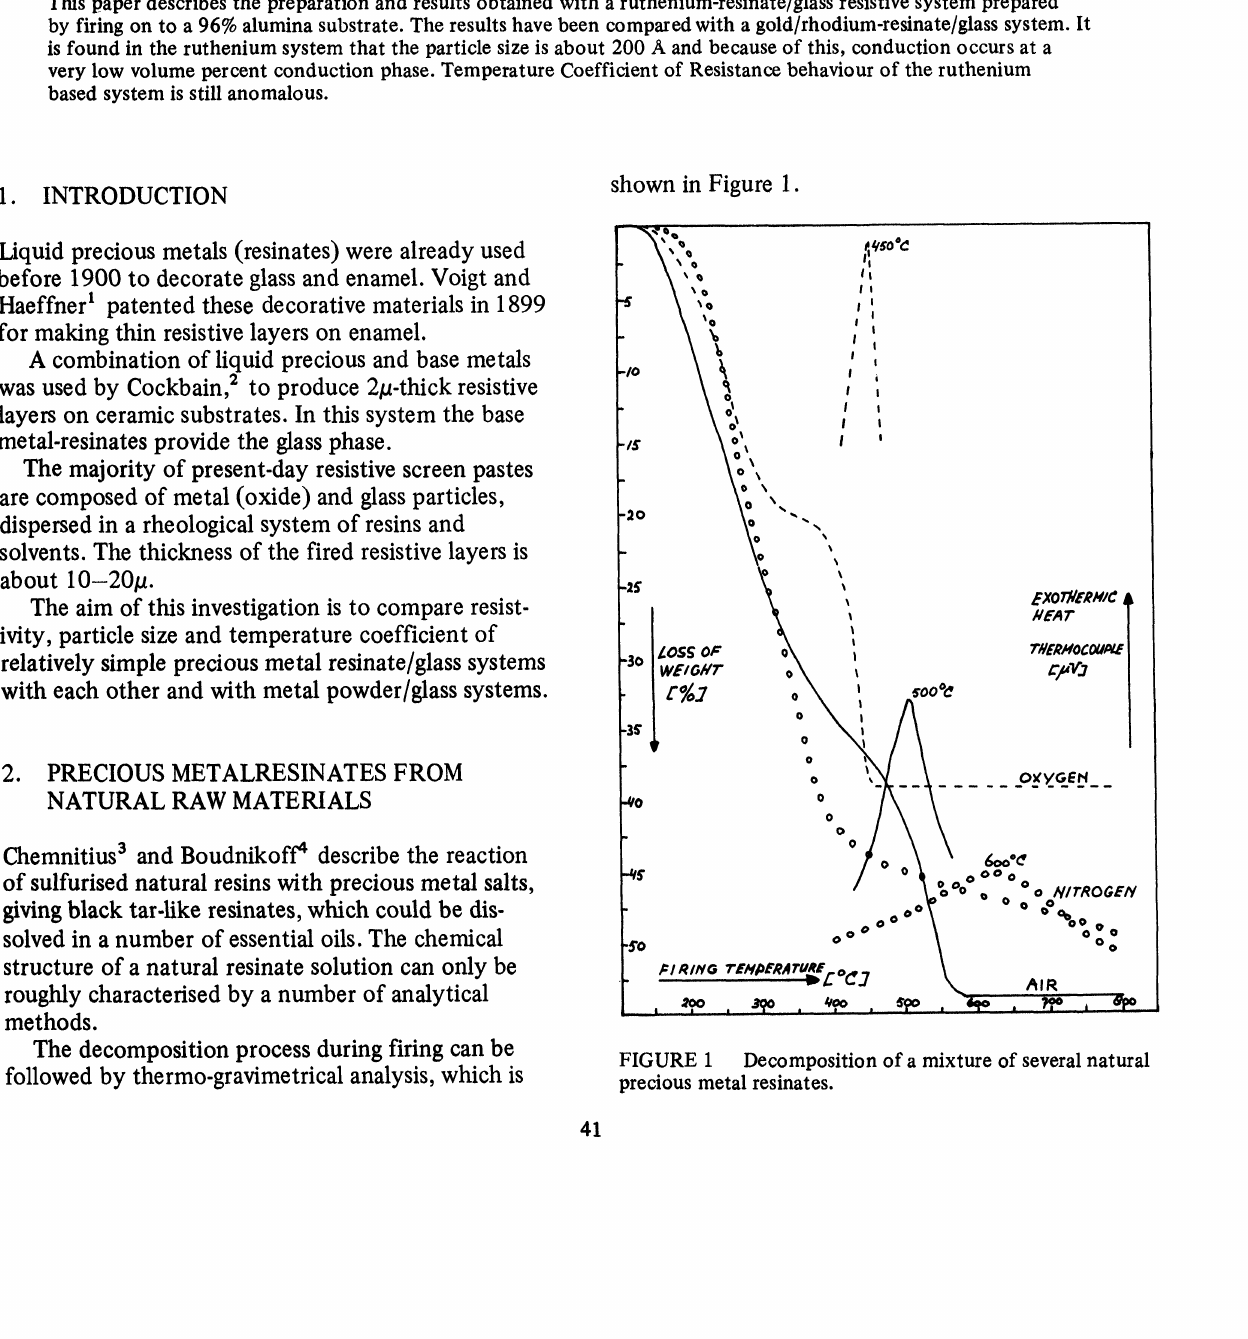
FIGURE Decomposition of a mixture of several natural precious metal